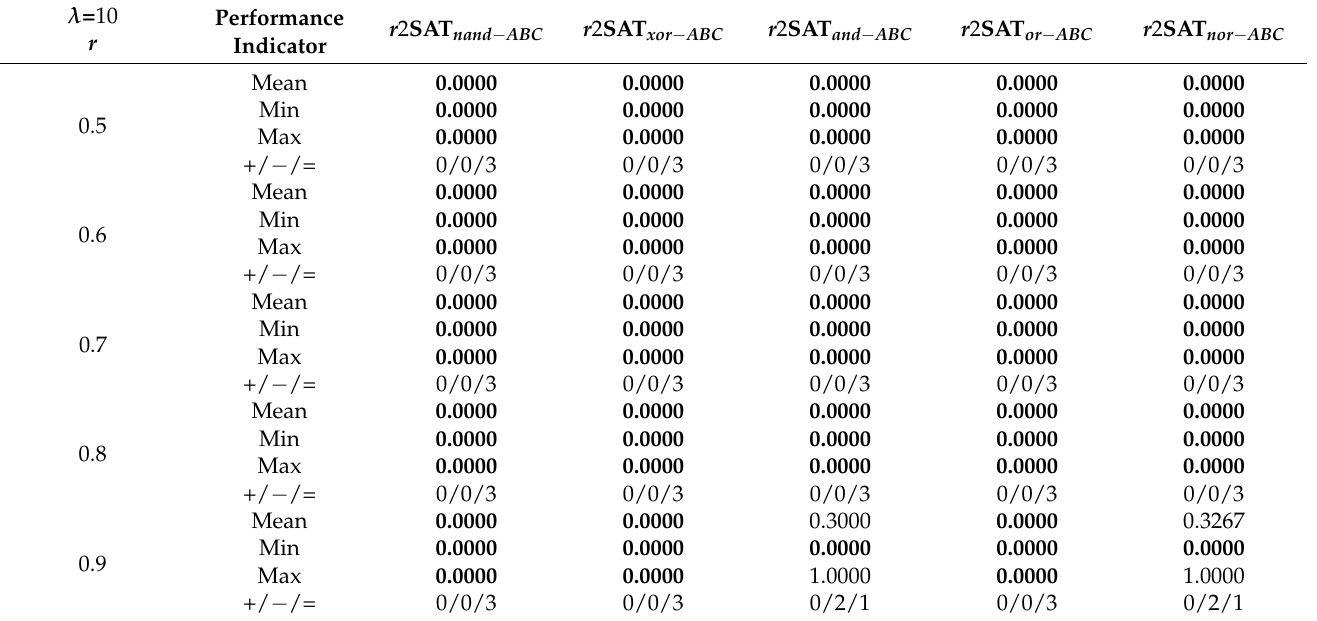
Table 12. Comparison of r 2SAT nand − ABC against other logic gates in terms of MAE for λ = 10.